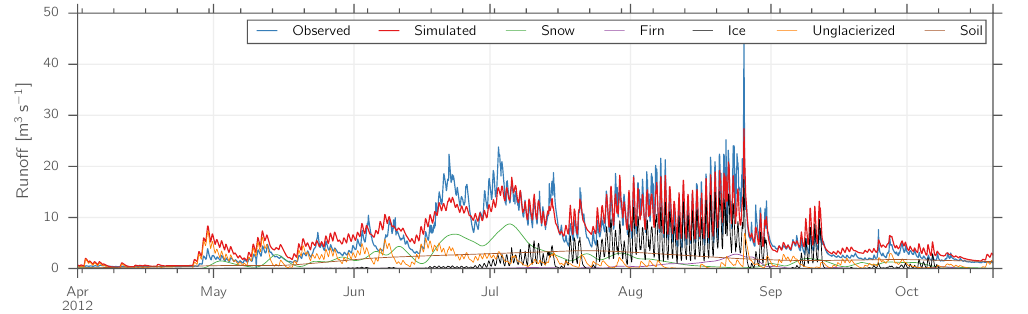
Figure 17. Observed vs. simulated runoff (including individual runoff components) for gauge Gepatschalm (1893–3526ma.s.l.) in the period April–October